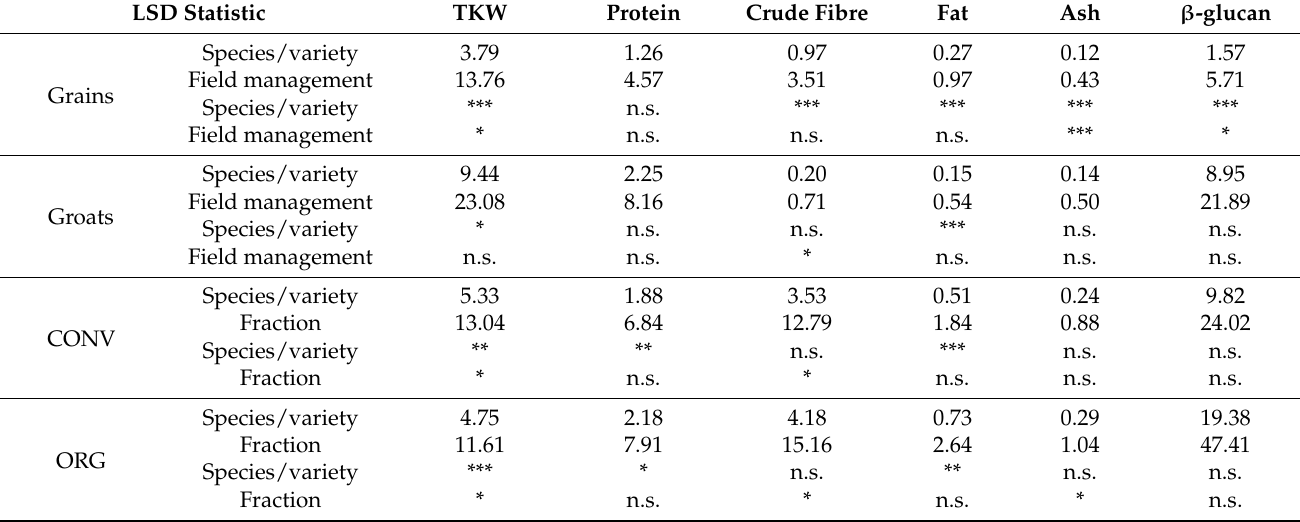
Table 3. Significant differences among the species/varieties and field management practices as shown by the LSD 5% values given for different fractions and field management